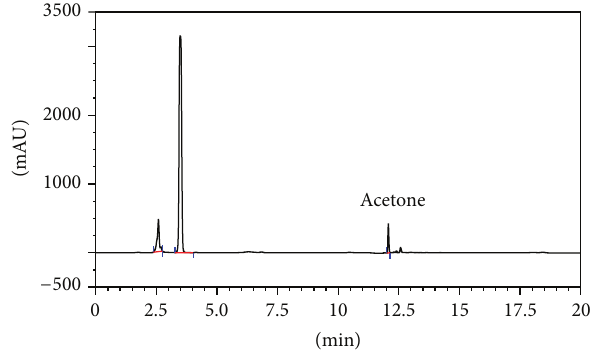
Figure 3: The HPLC chromatogram of 15mmol L −1 acetone in human blood from first patient of Group 1; for chromatographic conditions: see Section